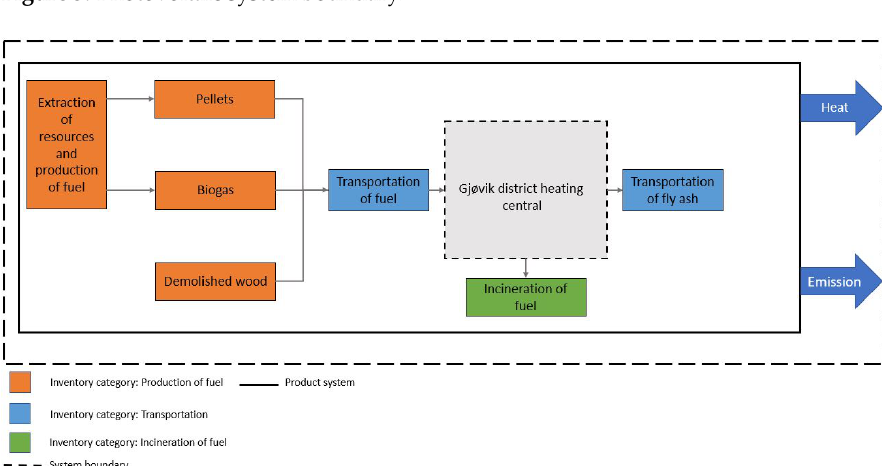
Figure 4. District heating system